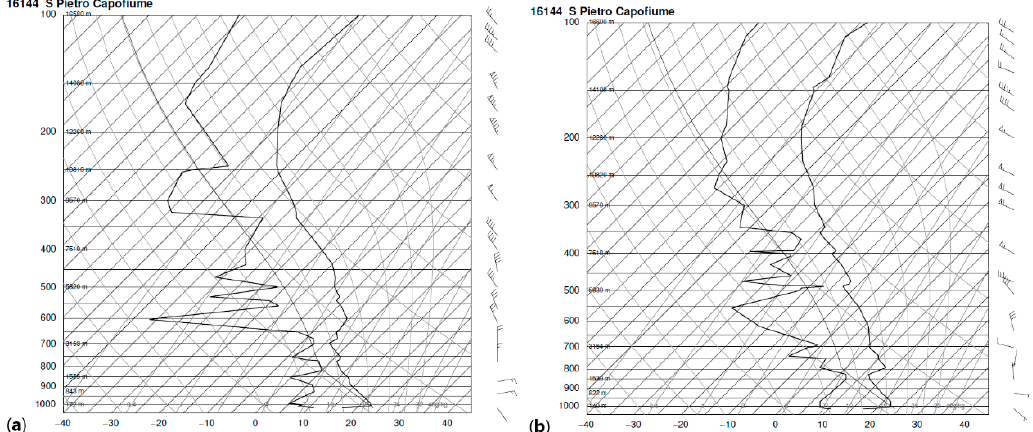
Figure A3. Atmospheric soundings on skew-T diagram obtained at the 0000 UTC of 22 ( a ) and 23 ( b ) August 2017 at San Pietro in Capofiume, 20 km north-north-east from Bologna. Within each plot, the leftish black line represents the dew point, the rightish black line is the temperature while the arrows are the wind speed in knots following the Beaufort scale (Source: http://weather.uwyo.edu/upperair/sounding.html).